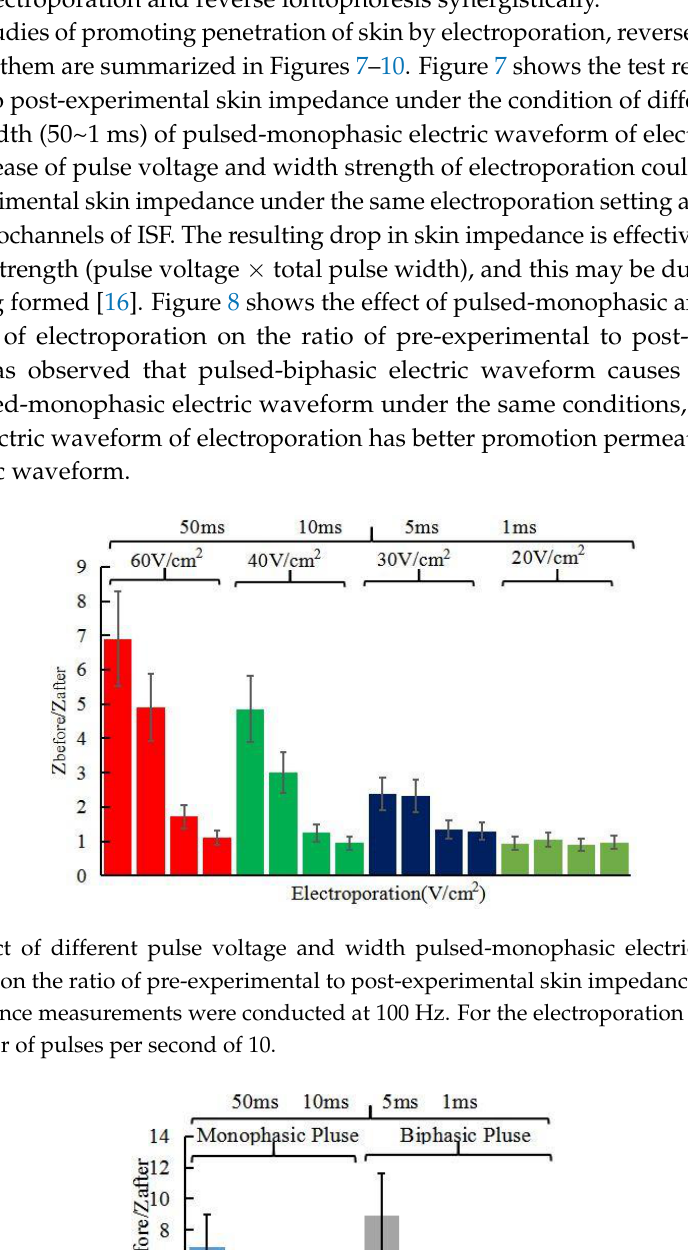
Figure 6. Output waveform of the reverse iontophoresis’s circle.